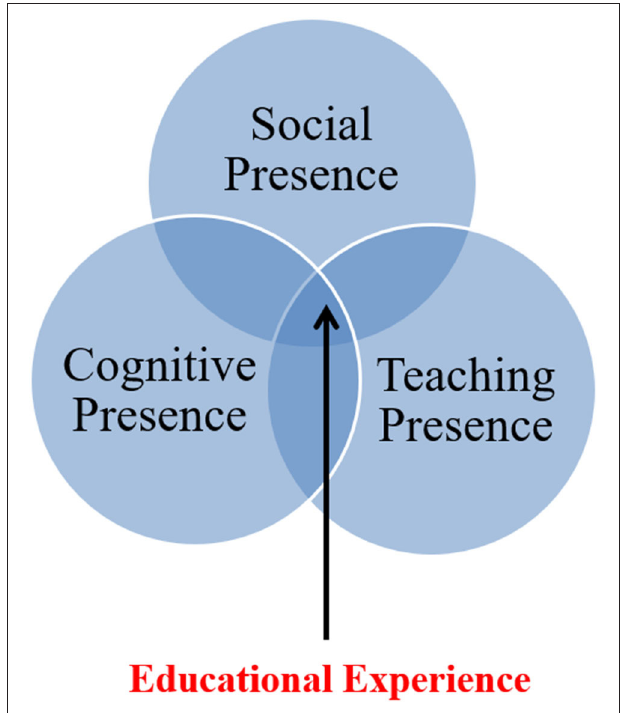
FIGURE 1 | The interrelated relationship of key elements in the CoI framework. Source: Garrison et al.